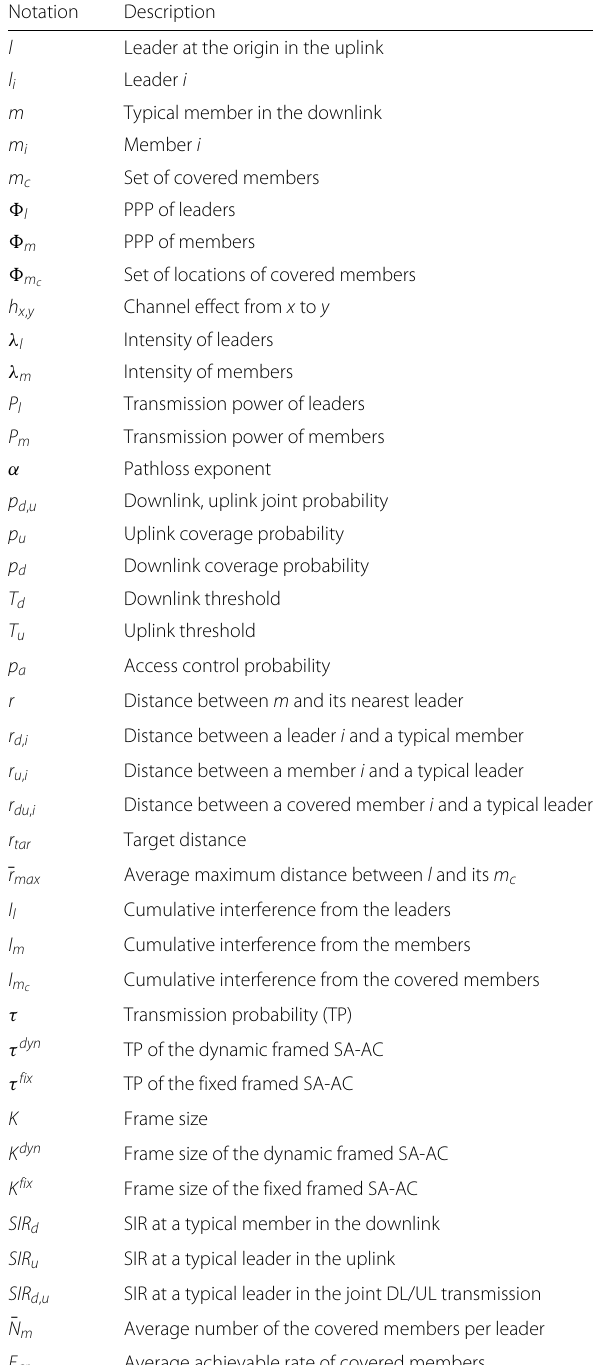
Table 1 Summary of